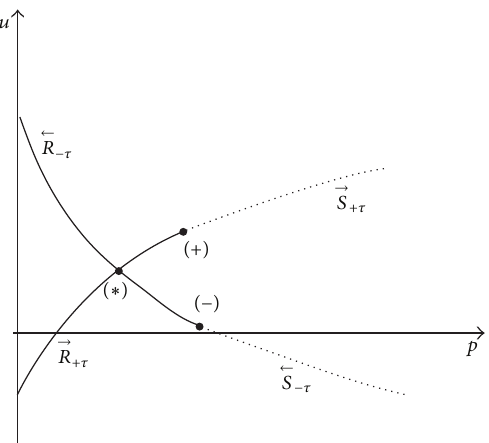
Figure 3: 𝑓 1 (0) > 𝑢 + = 𝑓 2 (𝑝 + )